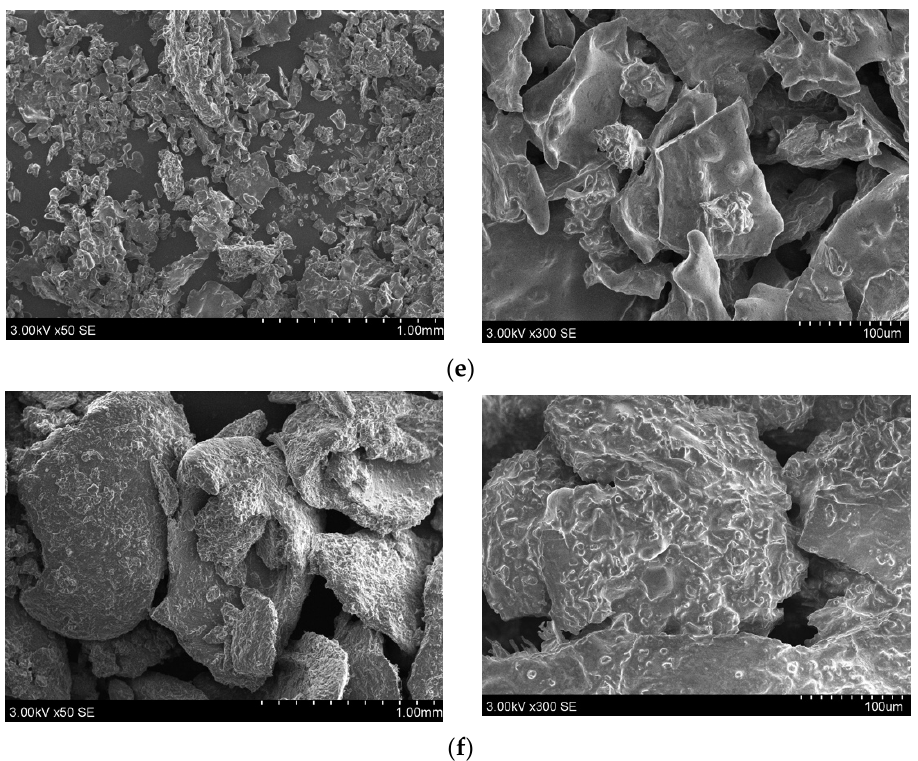
Figure 4. SEM morphology images of A. cordata freeze-dried samples powders ( a ) root, ( b ) stem, ( c ) leaf, ( d ) inflorescence, ( e ) berry, ( f ) seed.